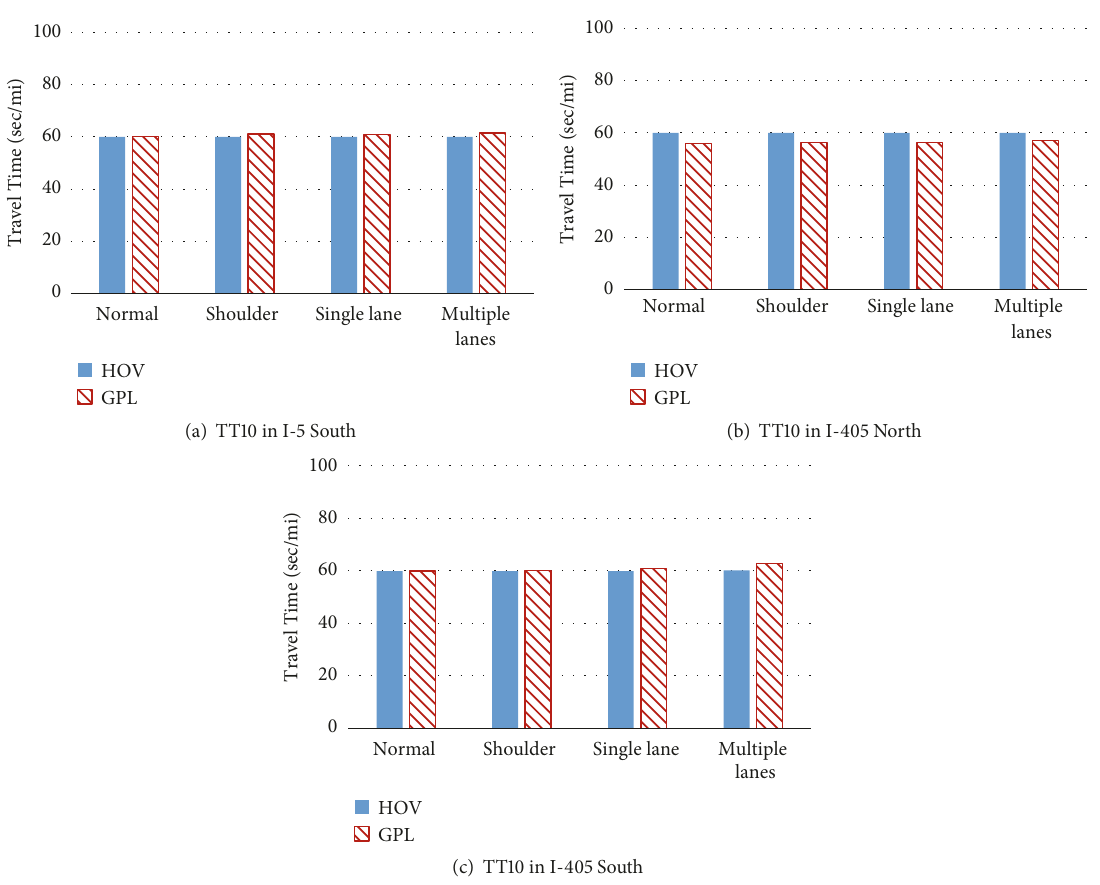
Figure 2: Comparison of 10th percentile travel time between HOV lanes and GPLs on I-5 South, I-405 North, and I-405 South. (a) TT10 in I-5 South. (b) TT10 in I-405 North. (c) TT10 in I-405